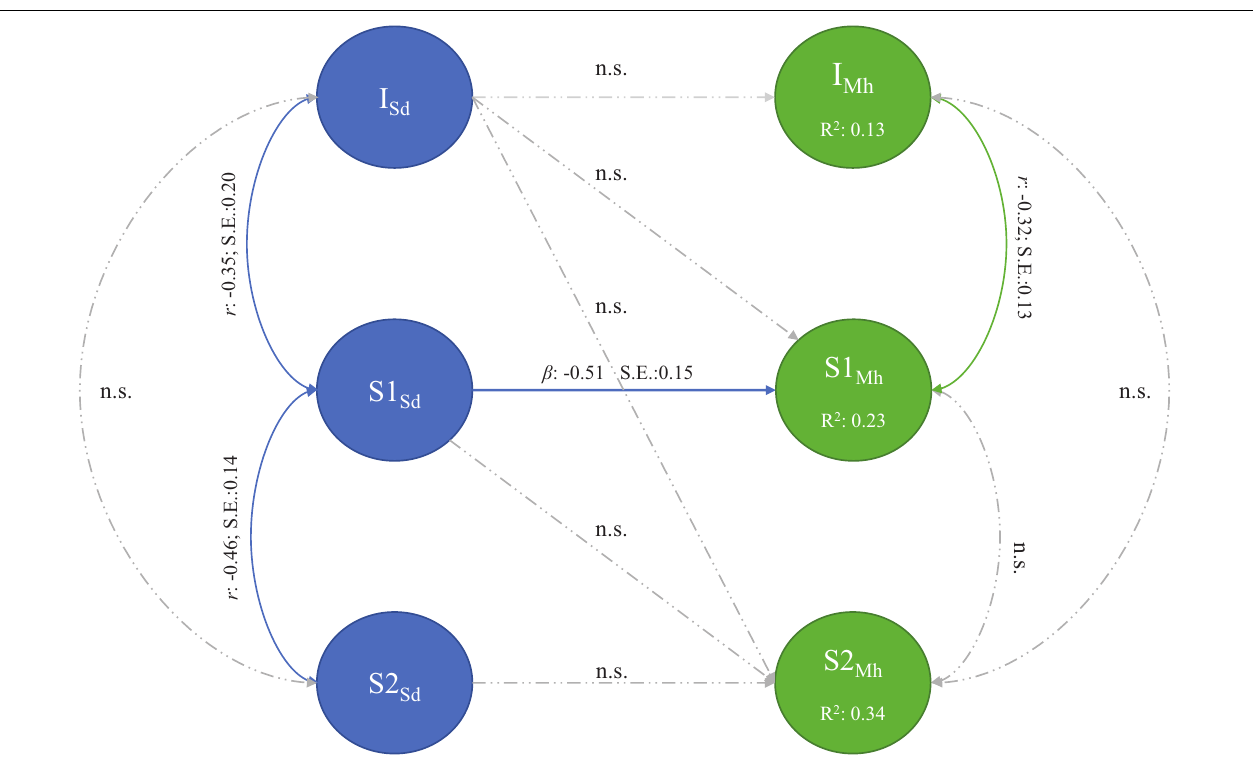
FIGURE 5 | Sequential piecewise multi-process latent growth model: study demands and mental